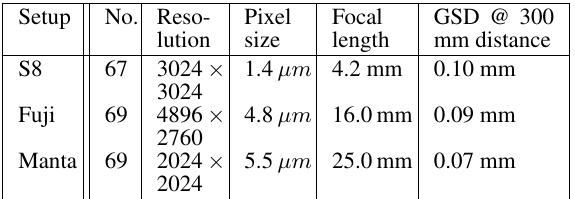
Figure 2. Laser triangulation setup with Sick Ranger camera, red line laser, and concrete plate on movable platform.